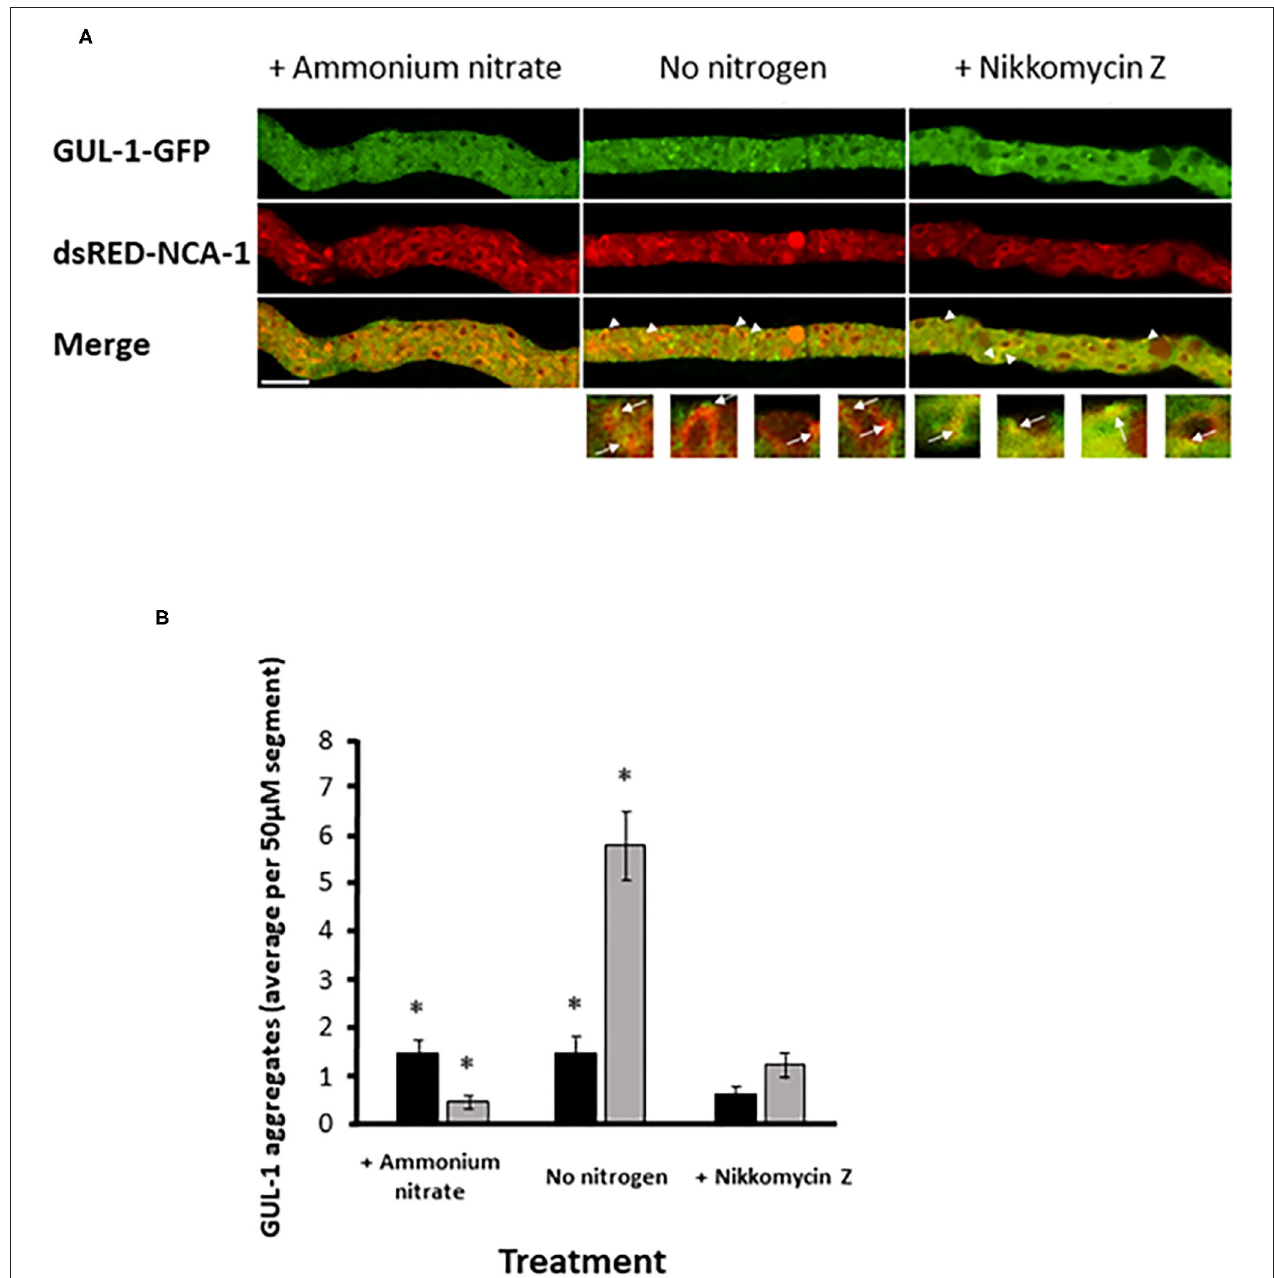
FIGURE 5 | Increase in GUL-1-GFP localization to the ER during stress conditions. GUL-1-GFP aggregates and dsRED-NCA-1 do not appear to co-localize when the fungus is cultured under standard growth conditions (panel A , left). When cultures are deprived of nitrogen or exposed to Nikkomycin Z some of the GUL-1-GFP aggregates co-localize with dsRED-NCA-1 (panel A ; arrowheads and arrows indicate the position of GUL-1-GFP aggregates localized in the ER). Scale bars: 10 µ m. (B) The number of NCA-1-associated GUL-1-GFP aggregates was determined in hyphal segments of cultures grown in the presence and absence of nitrogen, and also in the presence of Nikkomycin Z ( n = 30, 24, and 18), Bars indicate standard error. Asterisks indicate significant differences as determined by Student’s t-text ( p ≤ 0.05).